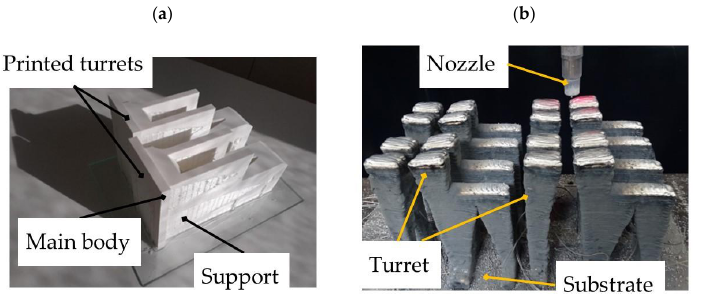
Figure 7. Manufacturing process of the turrets with ( a ) FDM and ( b ) WAAM technology.